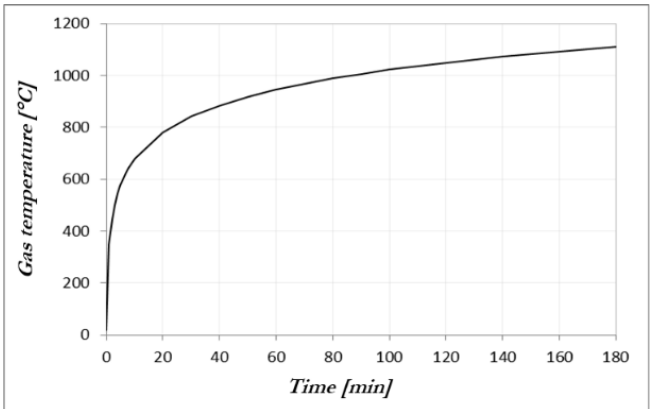
Figure 1. Standard temperature-time curve suggested by ISO 834